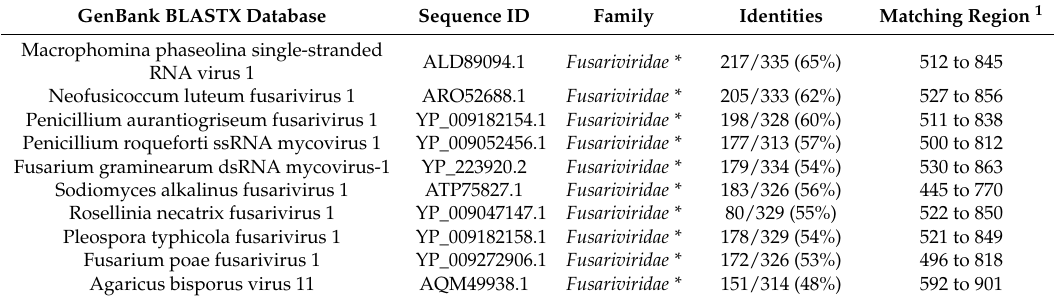
Table 2. BLASTX comparison of a 2228 bp RdRp sequence obtained from cloning 6 kb dsRNA of P3-7 G. abietina isolate.